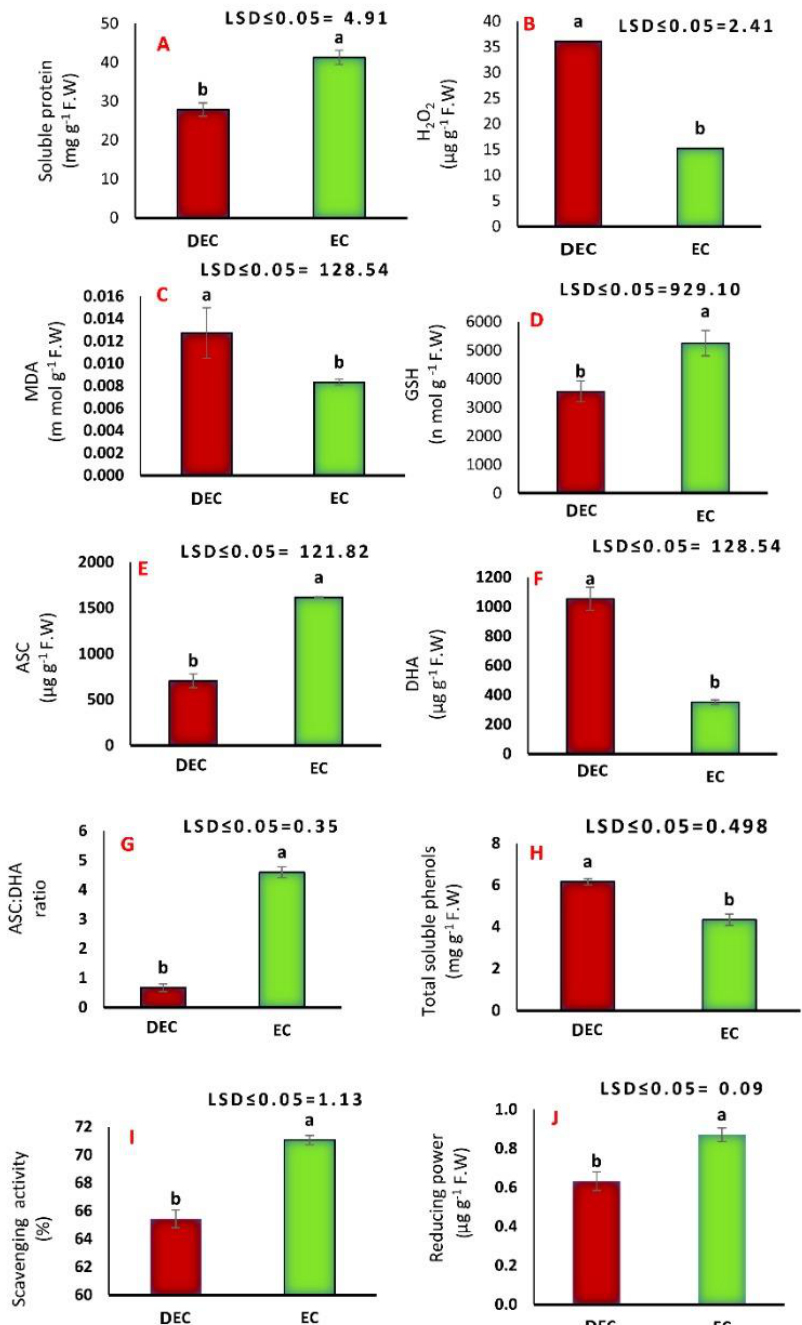
Figure 4. Variations in the levels of different endogenous soluble protein ( A ), hydrogen peroxide (H 2 O 2 ) ( B ), malondialdehyde (MDA) ( C ), reduced glutathione (GSH) ( D ), ascorbic acid (ASC) ( E ), dehydroascorbate (DHA) ( F ), ASC: DHA ratio ( G ), total soluble phenols ( H ), scavenging activity on DPPH radical ( I ) and reducing power ( J ) in DEC and EC of Phoenix dactylifera cv. Barhee after 8 weeks on a culture medium containing ABA at 0.5 mg L − 1 and PEG at 5 g L − 1 . Bars represent the mean ± standard deviation of three replicates; bars referred to using the same letter are not significantly different using Tukey’s test at p ≤ 0.05.